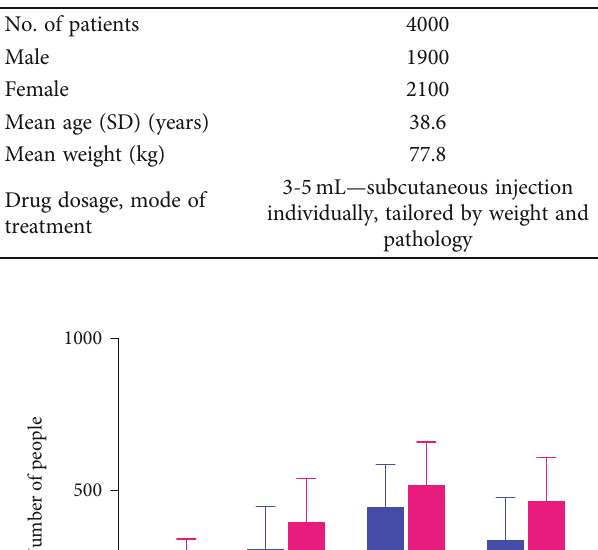
Table 1: Patient clinical characteristics (sex, age, and weight). No.: number of patients; SD: standard deviation; kg: kilograms.